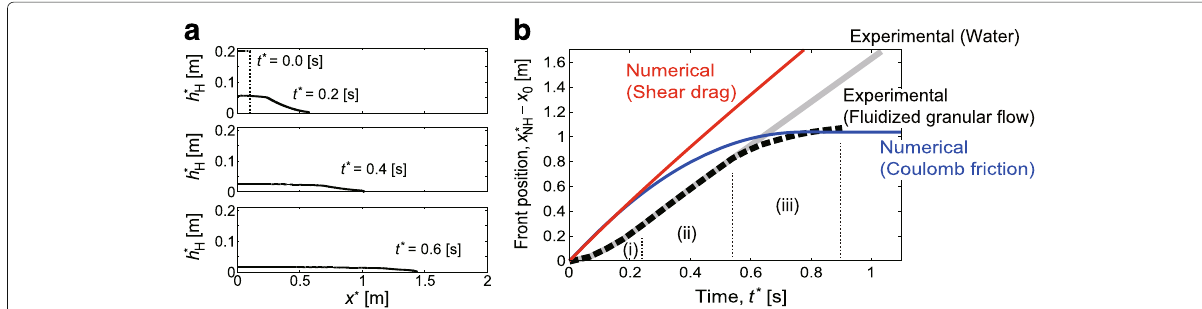
Fig. 11 Numerical results of a one-layer dense PDC model for the dam-break problem. The density ratio ( ρ H /ρ a ) is set to 600.6, and the AB model with ε = 10 − 10 is applied. Given parameters: initial height h 0 = 0.2 m, initial length x 0 = 0.1 m, density of particles = 1500 kg/m 3 ; density of of the dense PDC with shear drag at t ∗ = 0.0, 0.2, 0.4, and 0.6 s. b Front positions volcanic gas = 1 kg/m 3 ; and density of air = 1 kg/m 3 . a Heights h ∗ H of the dense PDC with shear drag ( redsolidcurve ) and Coulomb friction ( bluesolidcurve ). In ( b ), the numerical results are compared with the experimental results of an initially fluidized granular flow ( blackdashedcurve ) and water ( graysolidcurve ) (Roche et al. 2008). The experimental result of the initially fluidized granular flow has three distinct regimes: (i) initial acceleration, (ii) constant velocity, and (iii) stopping (see Roche et al. 2008 for details). Note that during (i) and (ii), the initially fluidized granular flow behaves as water. The numerical result with shear drag reproduces the slope (i.e., the constant velocity) of (ii). The numerical result with Coulomb friction reproduces the features of